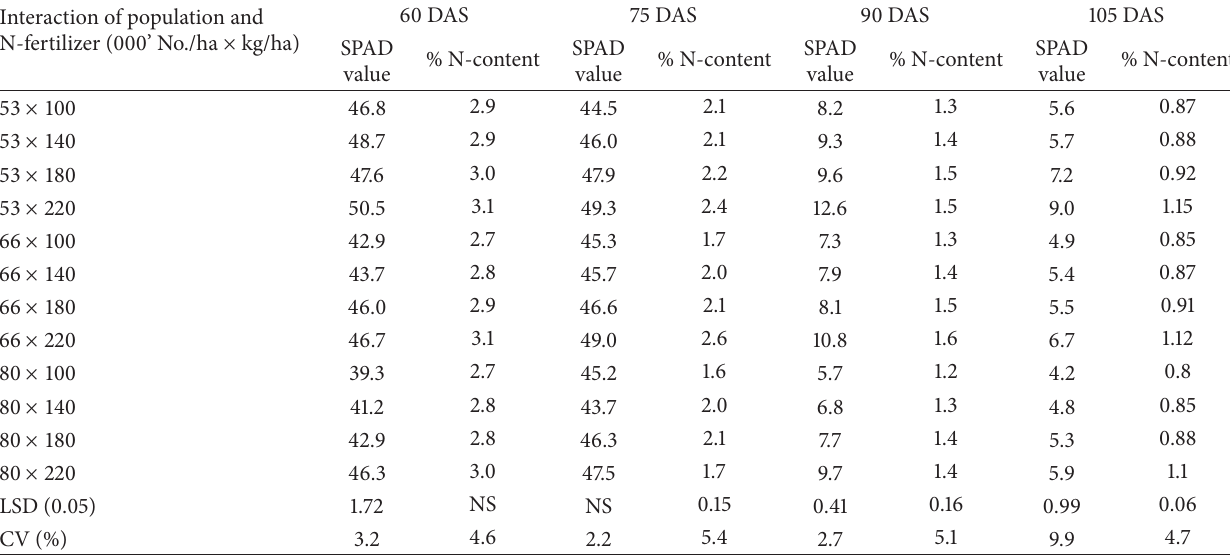
Table 2: Effect of N-fertilizer and plant density on SPAD value and N-content in maize leaf at different growth stages. 60 DAS Interaction of population and N-fertilizer (000’ No./ha × kg/ha)